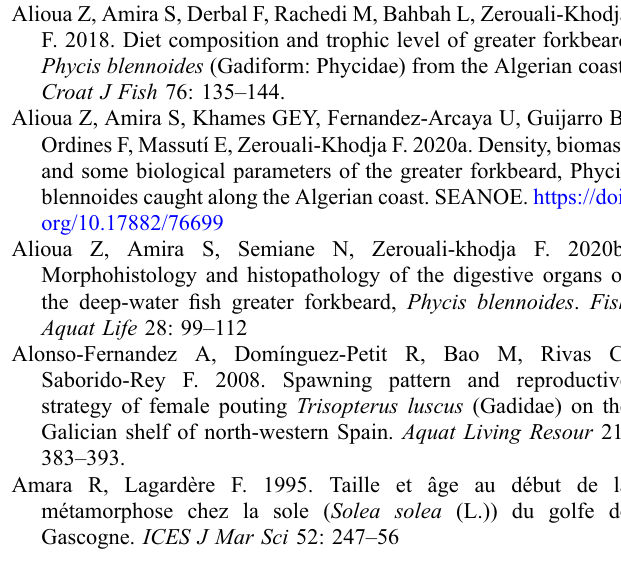
Fig. S1. Length frequency of P. blennoides caught from 52 hauls in 2003 (A) and from 109 hauls in 2004 (B) (n: number of individuals). Fig. S2. Linear model (LM) of log density of P. blennoides with depth (m) and longitude ( ° ) caught by the bottom trawl surveys in 2003 (A1, A2) and 2004 (B1, B2) along the Algerian coast ( (cid:1) :signi fi cant).